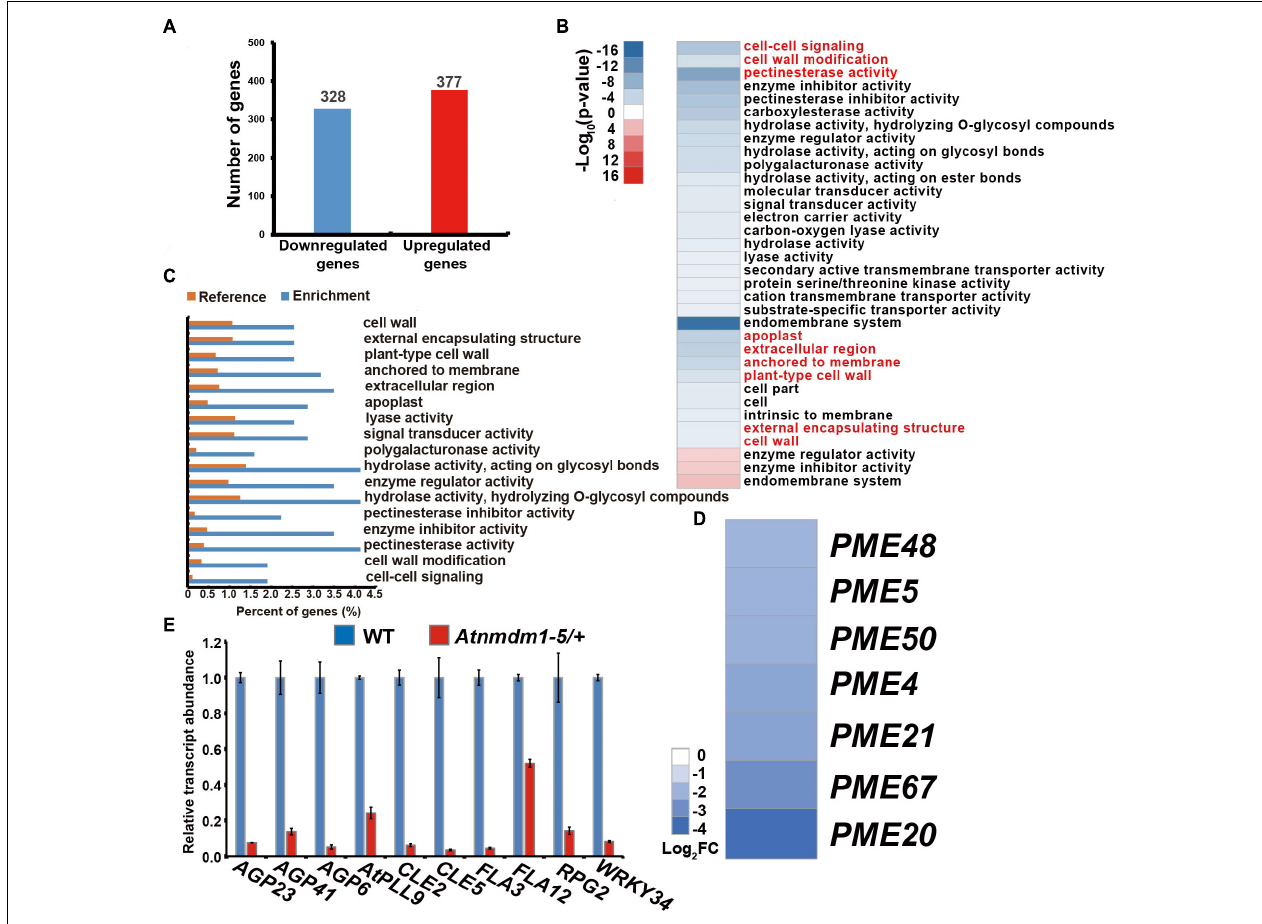
FIGURE 7 | Transcriptome and RT-qPCR analysis of wild-type and Atnmdm1-5/ + stages 8 and 9 anthers. (A) The number of differentially expressed genes (DEGs) in Atnmdm1-5/ + relative to the wild type (log2FoldChange > 1 or log2FoldChange < -1, P -value > 0.05). (B) Heat map showing the functional annotation of genes with upregulated and downregulated expression in Atnmdm1-5/ + relative to the wild type. (C) Histogram showing the enrichment of genes with downregulated expression in Atnmdm1-5/ +. (D) Heat map showing 7 pectin methylesterase (PMEs) genes with downregulated expression in Atnmdm1-5/ +. (E) RT-qPCR analysis of intine and signal pathways associated with gene expression in the wild type and Atnmdm1-5/ + at the anther stages, 9 and 10. Data were normalized to EF2 α expression. The bars represent mean ± SE of three biological